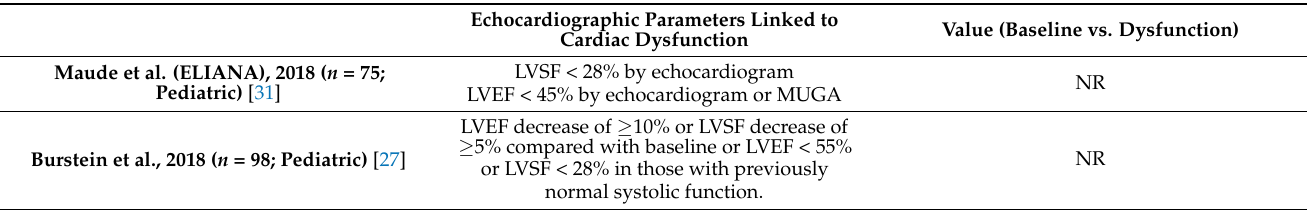
Table 5. Echocardiographic parameters involved in chimeric antigen receptor T-Cell therapy- associated cardiac